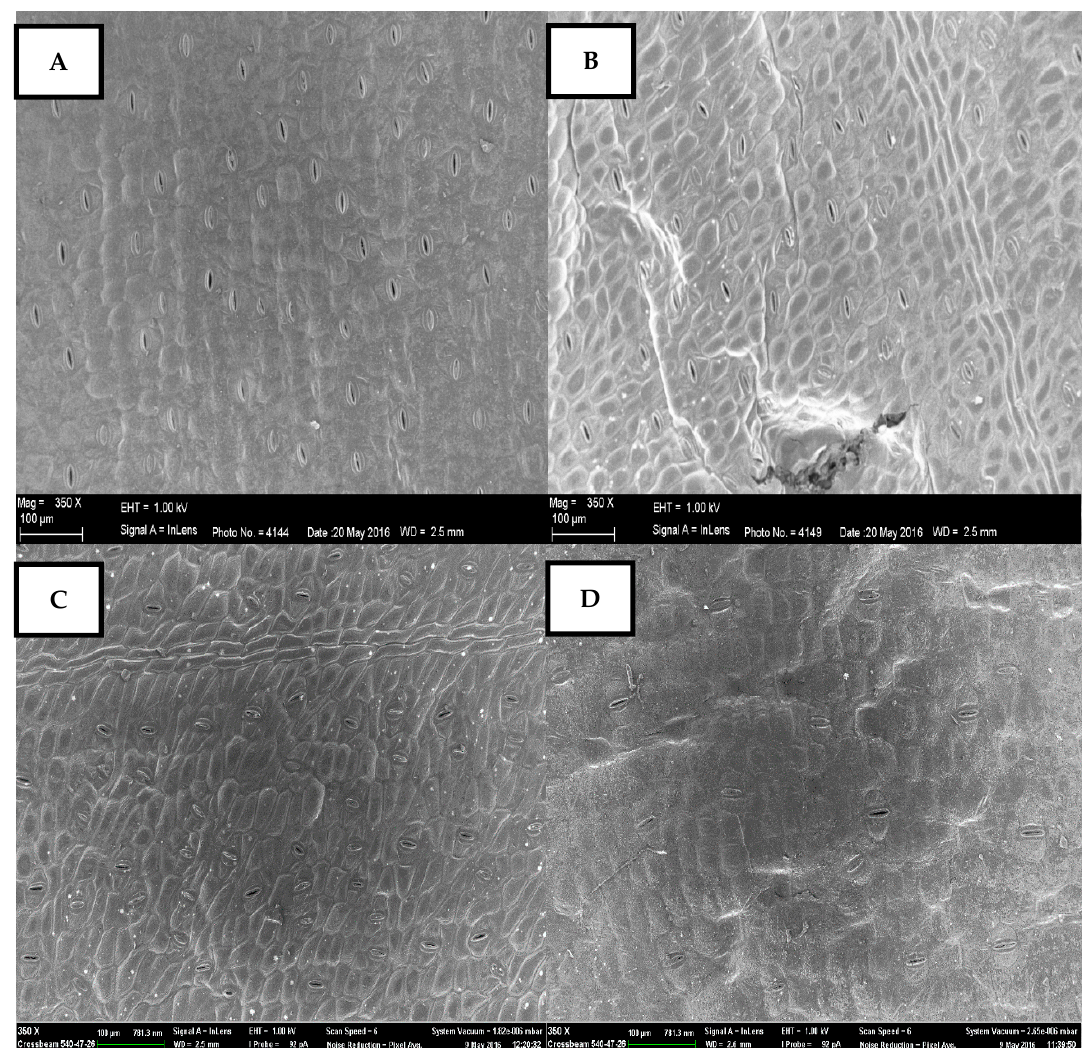
Figure 6. Scanning Electron Microscopy (SEM) images of open stomata pores of commercial ginger in response to different irrigation regimes during cropping season 2015/2016. ( A ) CG-20–25% MAD; ( B ) CG-40–45%MAD; ( C ) CG-60–65% MAD; and, ( D ) CG-80–85%